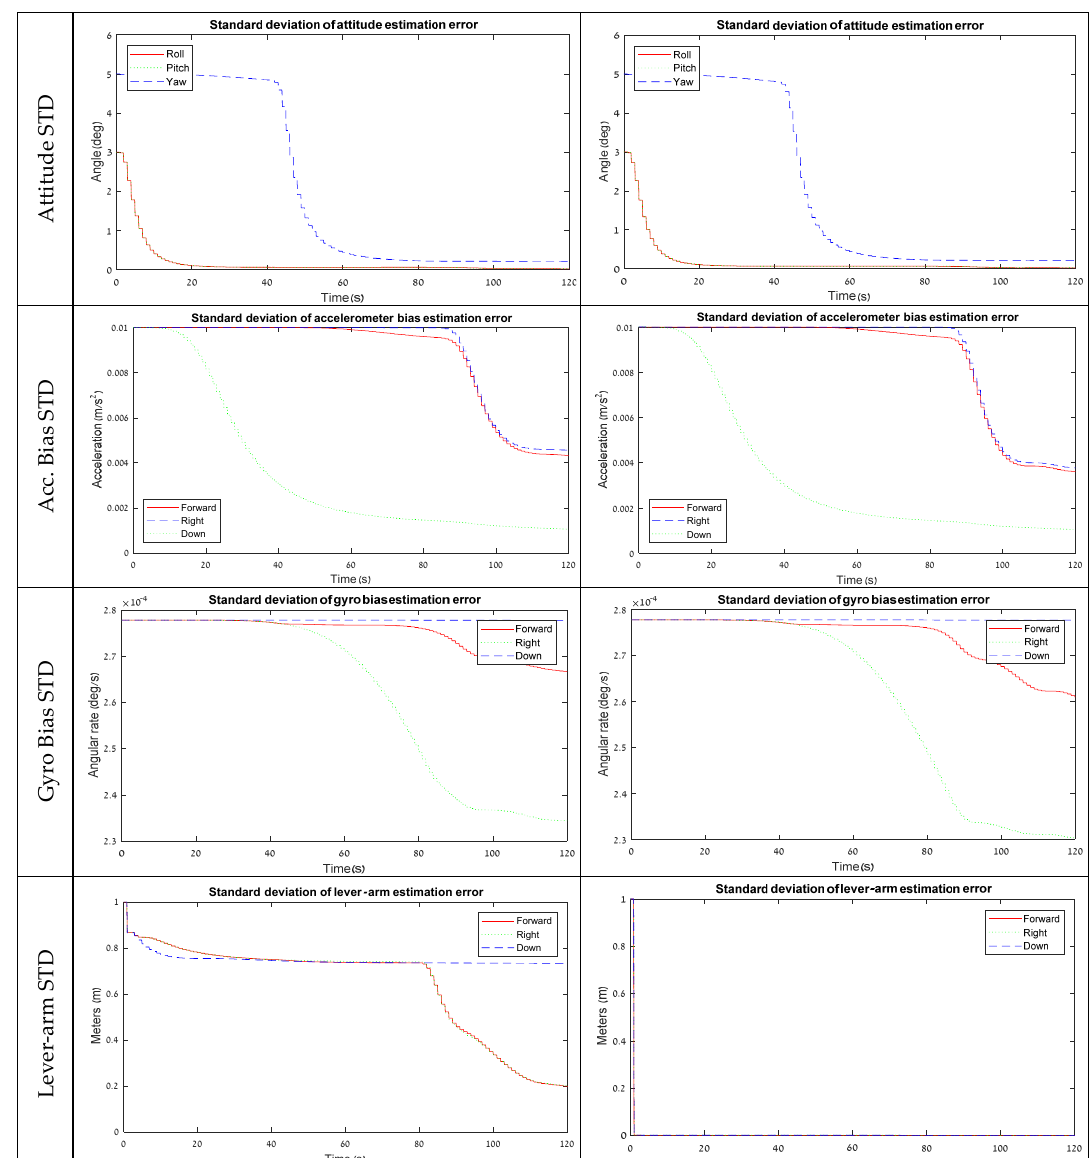
Figure 3. STD results from the software simulation for a position ‐ aided system with and without VLA.